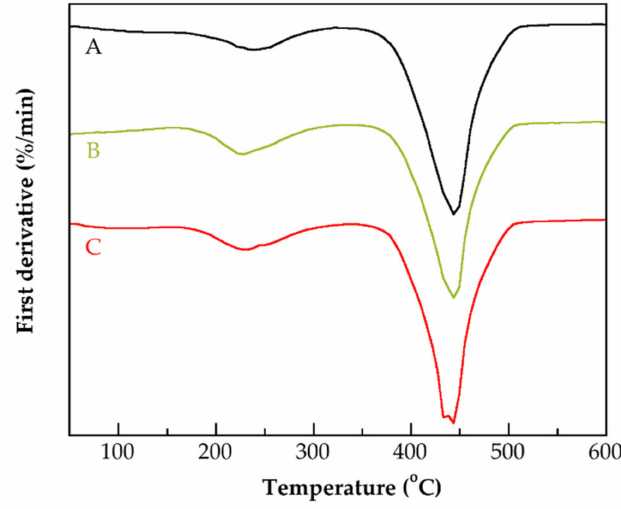
Figure 10. DTG thermograms of PMAA 3 ( A ), PMAA-G 3.0 -CNTs 5 ( B ), and PMAA-G 3.0 -CNTs 6 ( C